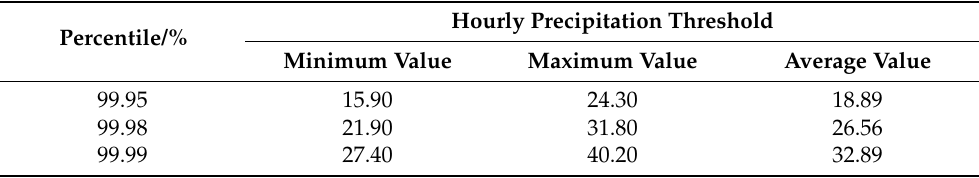
Table 1. Hourly heavy precipitation thresholds at different percentiles in the TGRR from 1998 to 2020.